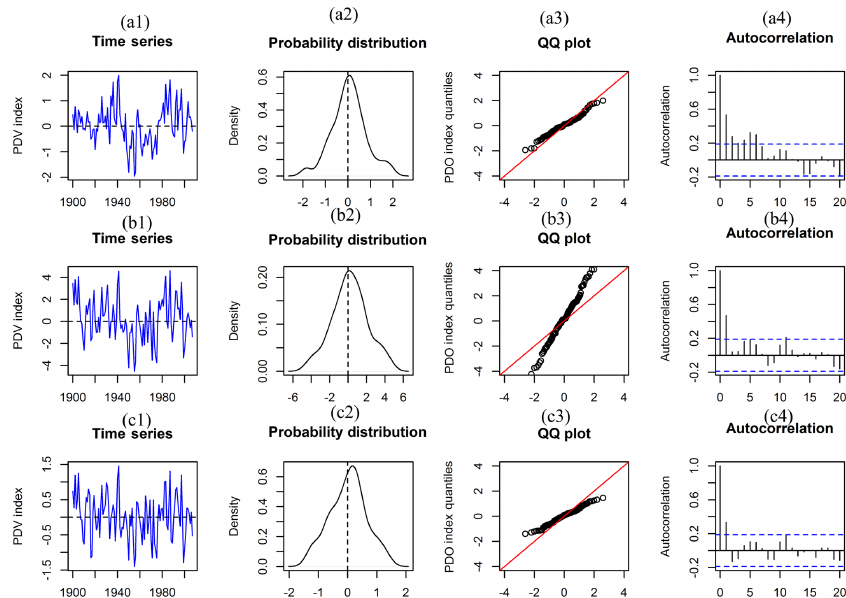
Figure 1. Annual instrumental time series, probability density plot, QQ plot and autocorrelation plot: (a) PDO from Mantua (1900– 2015); (b) IPO from Parker (1871–2007); (c) IPO from Henley